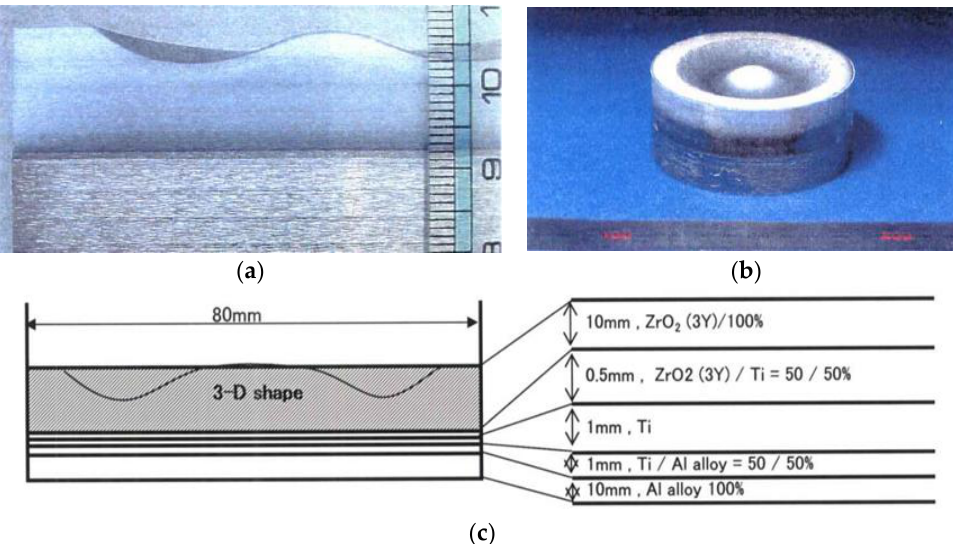
Figure 33. Example of Φ80 mm large size ZrO 2 (3Y)/Ti/Al alloy system FGMs: ( a ) Cross section of SPSed 3D shaped FGMs specimen; ( b ) Outside view of Φ80 mm ZrO 2 (3Y)/Ti/Al alloy 3D FGMs; ( c ) Dimensions and profile of 3D FGMs.